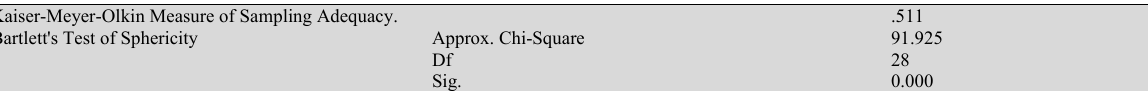
KMO and Bartlett's Test Kaiser-Meyer-Olkin Measure of Sampling Adequacy.